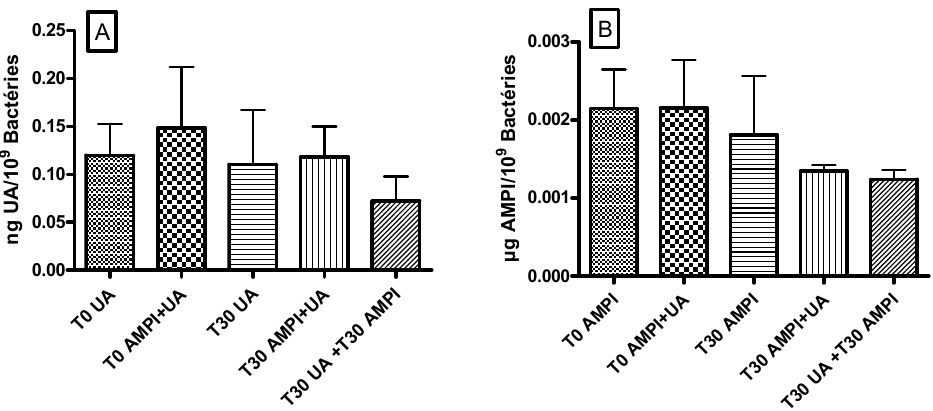
Figure 3. Accumulation of UA (Ursolic acid) ( A ) or AMPI (ampicillin) ( B ) in the presence of ampicillin ( A ) or UA ( B ) in S. aureus ATCC 33591. In the co-incubation protocol, both compounds were co- incubated for 30 min (T30 AMPI + UA). For the pre-incubation protocol, UA was incubated for 30 min before the addition of ampicillin for 30 min more (T30 UA + T30 AMPI) or the opposite (ampicillin was incubated for 30 min before the addition of UA for 30 min more (T30 AMPI + T30 AMPI). The accumulation was expressed in ng ursolic acid/10 9 bacteria or µ g ampicillin/10 9 bacteria. The data represent the mean ± SEM of three independent